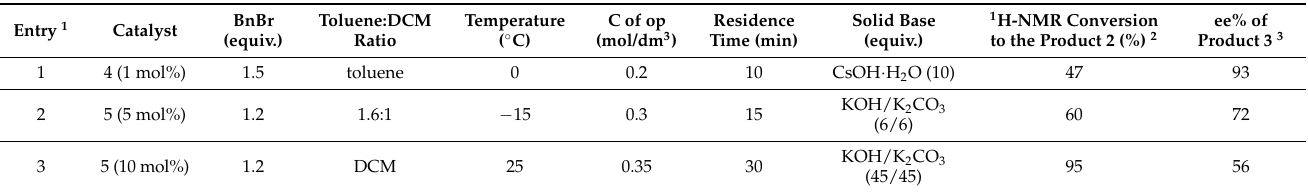
Table 4. Solid-liquid asymmetric phase transfer benzylation of L-alanine imine 1 in flow using packed-bed reactor-reaction mixture delivered by Vapourtec system (Figure